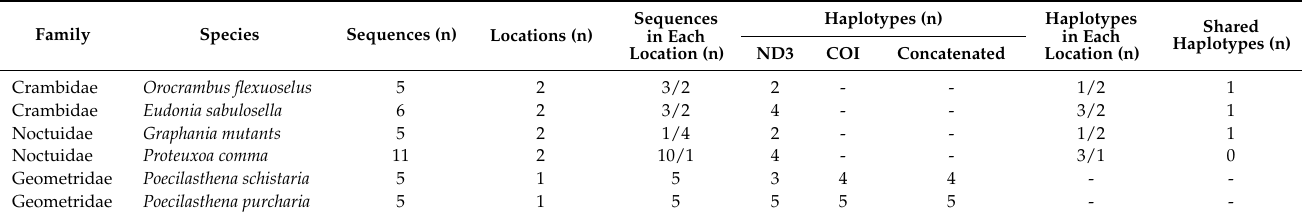
Table 6. Haplotypes identified within locally collected